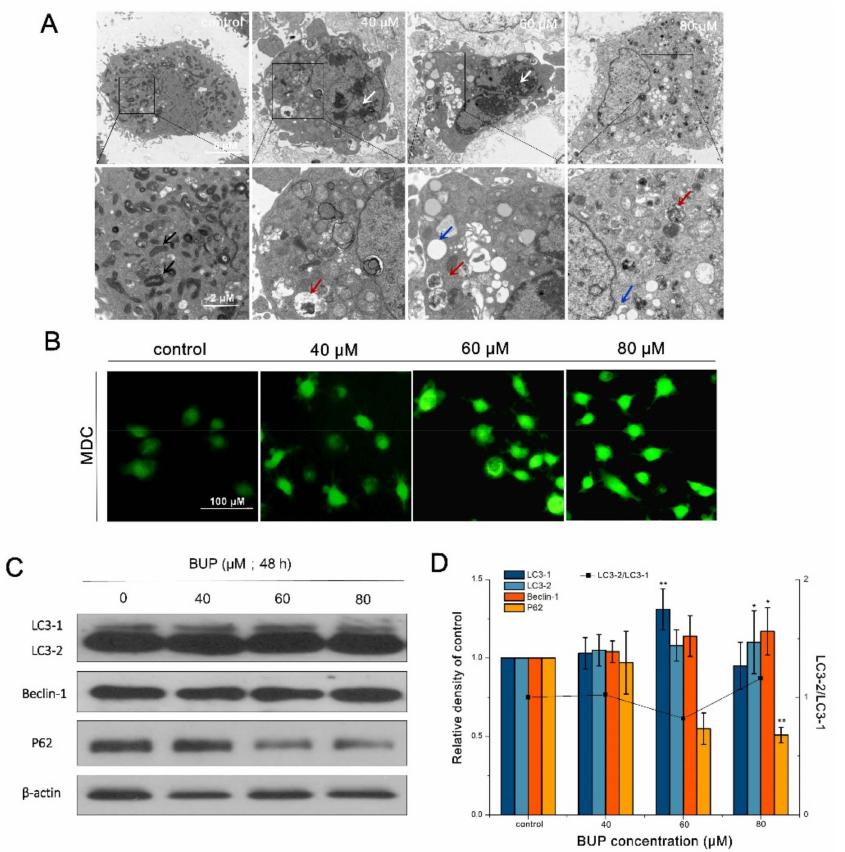
Figure 7. Investigation of autophagic effects of A549 cells after exposure to BUP at different con- centrations, showing: ( A ) observation of autophagic submicrostructure via TEM, normal cells with mitochondria in elliptical shape (black arrows), BUP-treated cells with autophagic vacuoles (blue arrows), autophagic vacuoles with content (red arrows) and chromatin condensation (white arrows); ( B ) observation of MDC dyeing by epifluorescence (200 × ); ( C ) detection of autophagy-related pro- teins; ( D ) expression of autophagy-related proteins. * p ≤ 0.05 and ** p ≤ 0.01 vs. the negative